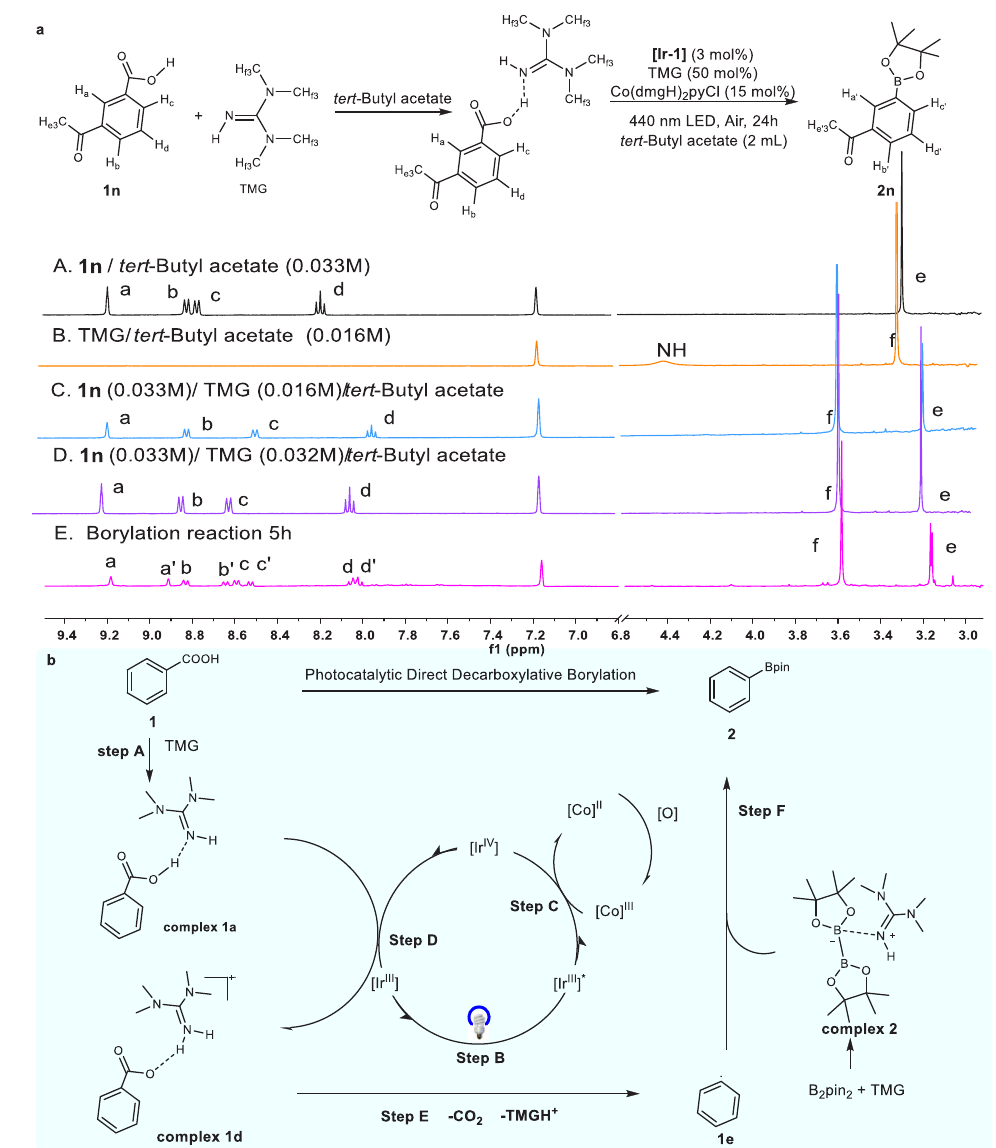
Fig. 4 | The proposed mechanism based on experimental exploration. a Condition of in situ 1 HNMR analysis A: 1n (0.33M) in AcO t Bu (the date shown as theblackline),B:TMG(0.016M)ininAcO t Bu(thedateshownastheorangeline),C: 1n (0.33M), TMG (0.016M) in AcO t Bu (the date shown as the blue line), D: 1n